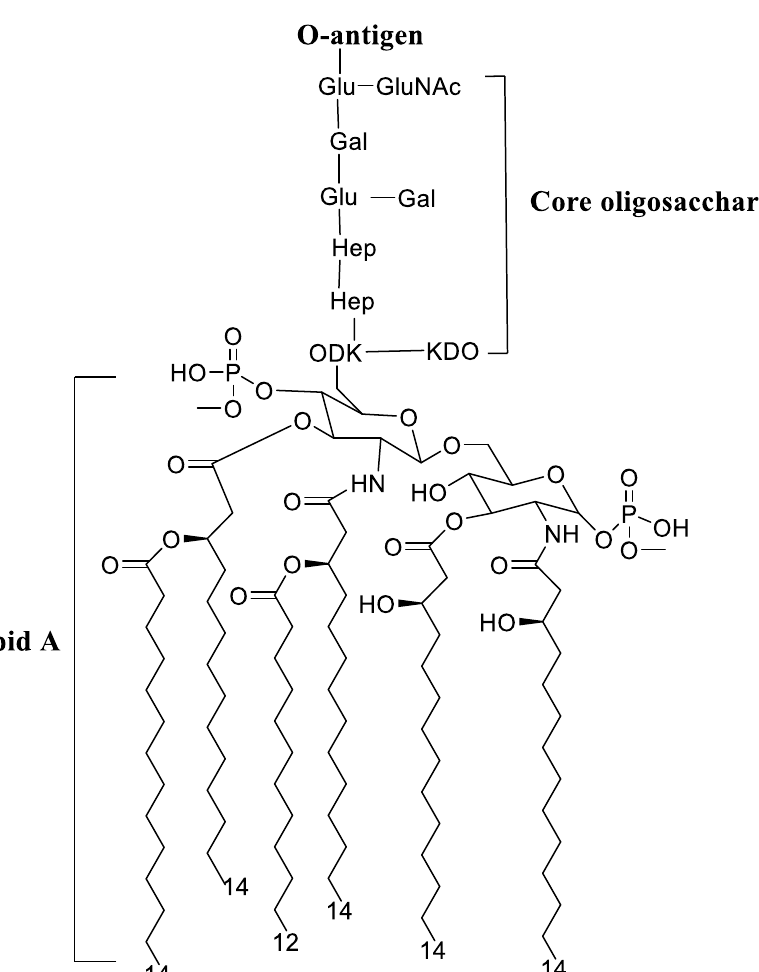
Figure 2. Structure of E. coli lipopolysaccharide. Abbreviations Gal: D-galactose; Glu: D-glucose; Hep: L-glycero-D-manno-heptose; KDO: 3-deoxy-D-manno-oct-2-ulosonic acid; P: